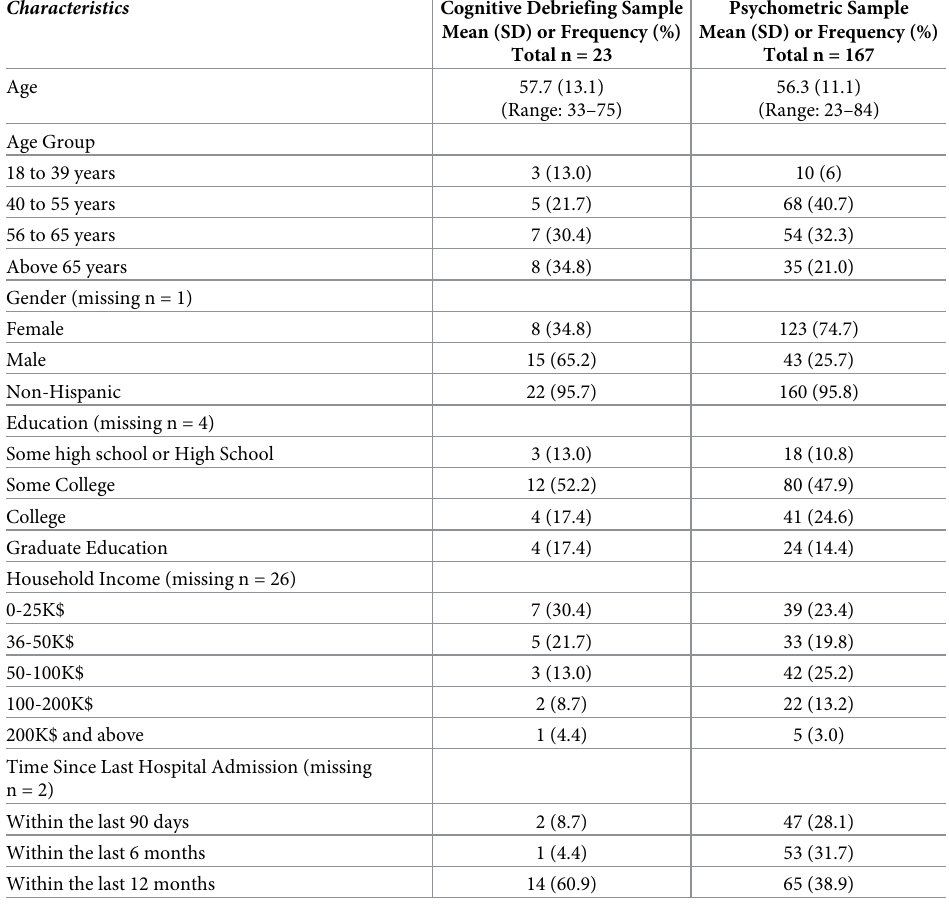
Table 1. Sociodemographic characteristics: Cognitive debriefing (qualitative) and psychometric (quantitative) phases.